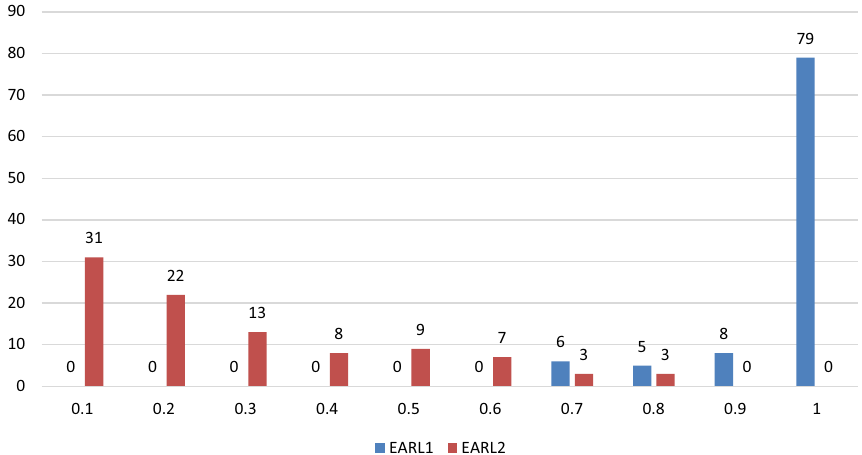
Fig. 4 Probabilities of the second network. These probabilities are representing the certainity of the network that an image is EARL1 compliant. If the probability is below 0.6 for an EARL2 compliant image, the image is still correctly classified. The network can identify EARL1 reconstructions very well why it has more difficulties with identifying EARL2 compliant images. As can be seen, by setting the threshold to separate these two reconstructions to 0.6 the overall accuracy